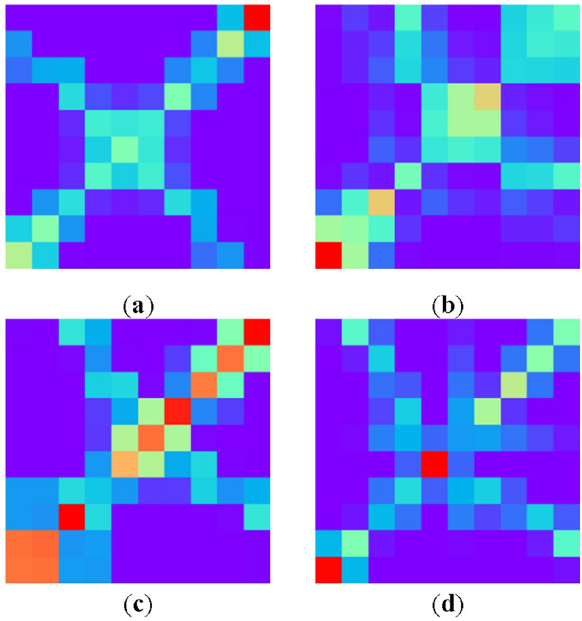
Figure 8. MTF two-dimensional time series images corresponding to four different types of small fishing vessels, ( a ) MTF images of small alloy fishing vessels, ( b ) MTF images of wooden fishing vessels, ( c ) MTF images of rubber inflatable fishing vessels, ( d ) MTF images of PE plastic fishing vessels.